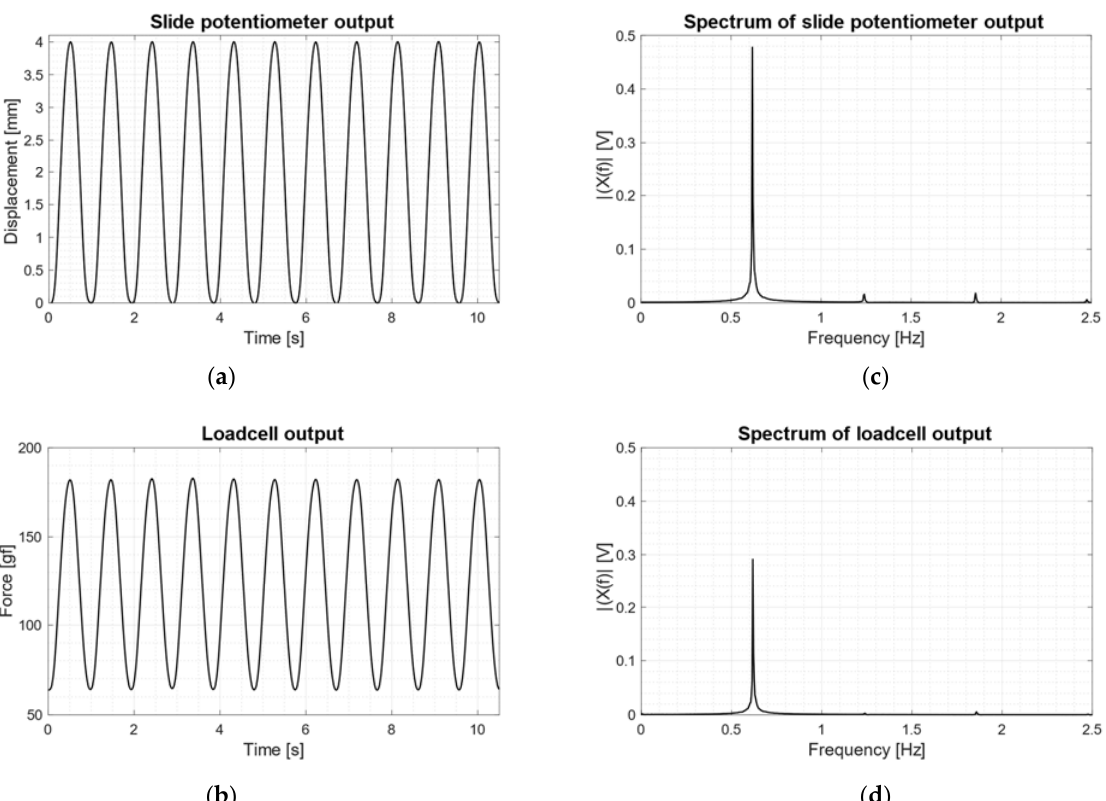
Figure 10. Recordings obtained with motor power supply set to 6 V, resulting in a stress frequency of 0.62 Hz: ( a ) slide potentiometer output in time domain; ( b ) loadcell output in time domain; ( c ) spectrum of slide potentiometer output (after DC removal); ( d ) spectrum of loadcell output (after DC removal).